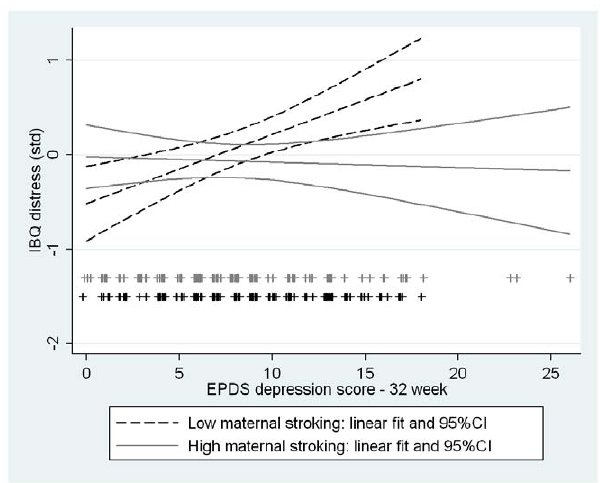
Figure 5. Interaction between maternal stroking and prenatal depression on infant distress to limitations. Simple regression lines and 95% confidence envelopes showing the interaction between maternal reports of stroking (median split) and prenatal depression, with infant IBQ distress to limitations at 29 weeks (p=0.007 from multivariate regression).